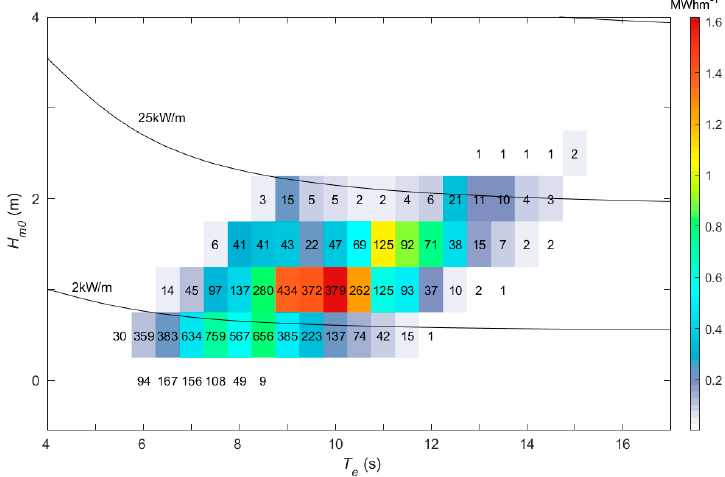
Figure 2. Annual characterization matrix of the wave energy resource at the point of interest. Numbers indicate the occurrence in annual hours of the sea states in each energy bin.